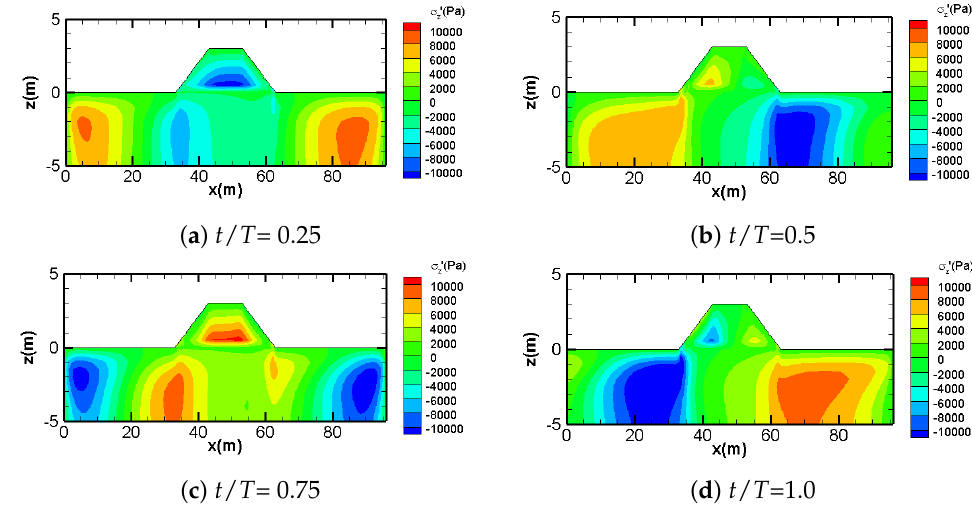
Figure 6. Distribution of the wave-induced vertical effective stress in the vicinity of the